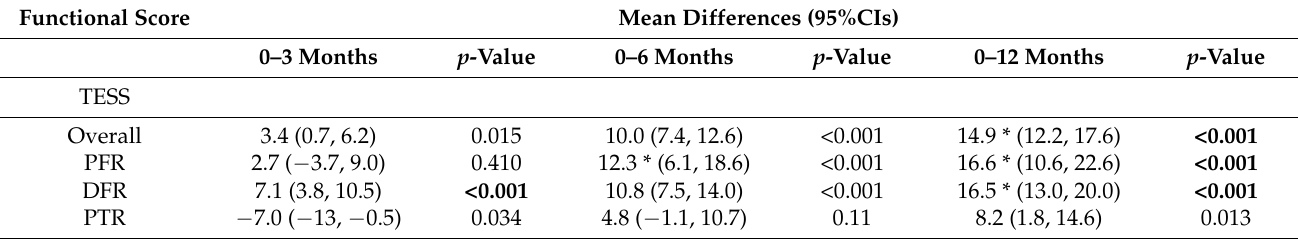
Table 3. TESS change scores over time.